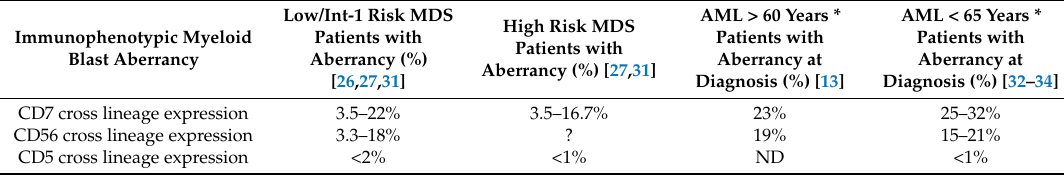
Table 1. Frequency of aberrant cross-lineage expression on myeloblasts in MDS versus AML. Low/Int-1 Risk MDS Immunophenotypic Myeloid Patients Blast Aberrancy